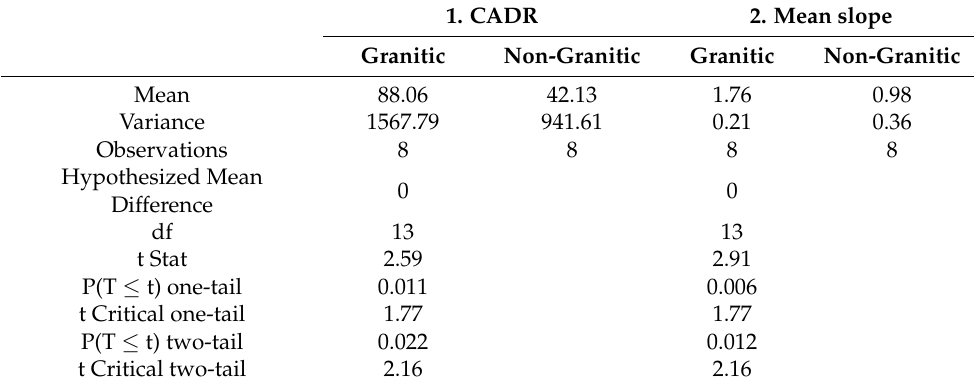
Table 5. Student’s t -tests results for rock